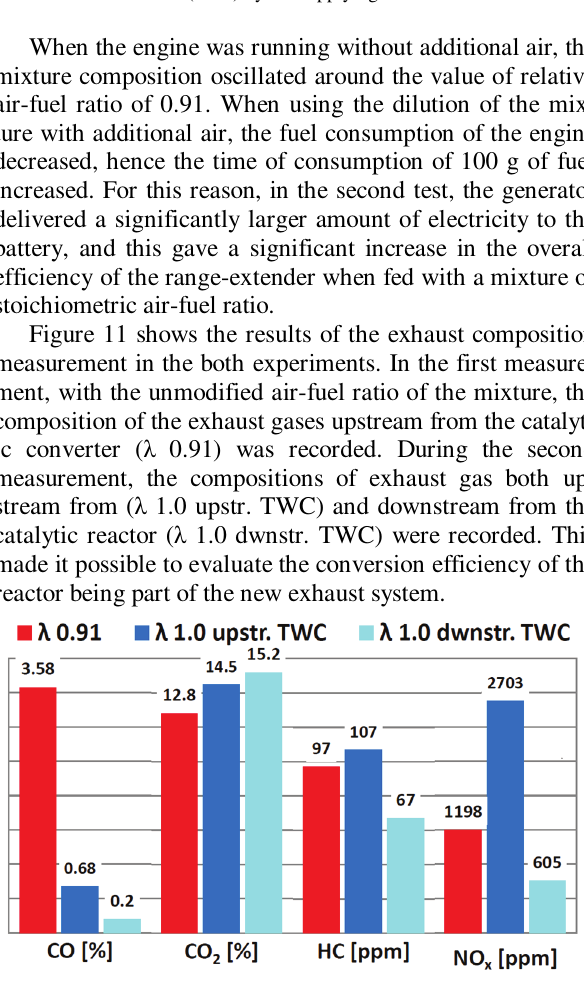
Fig. 10. Comparison of energies delivered to battery and efficiencies of the range extender working with factory settings ( λ 0.91) and with a modified relative AFR ( λ 1.0) by the supplying of additional air